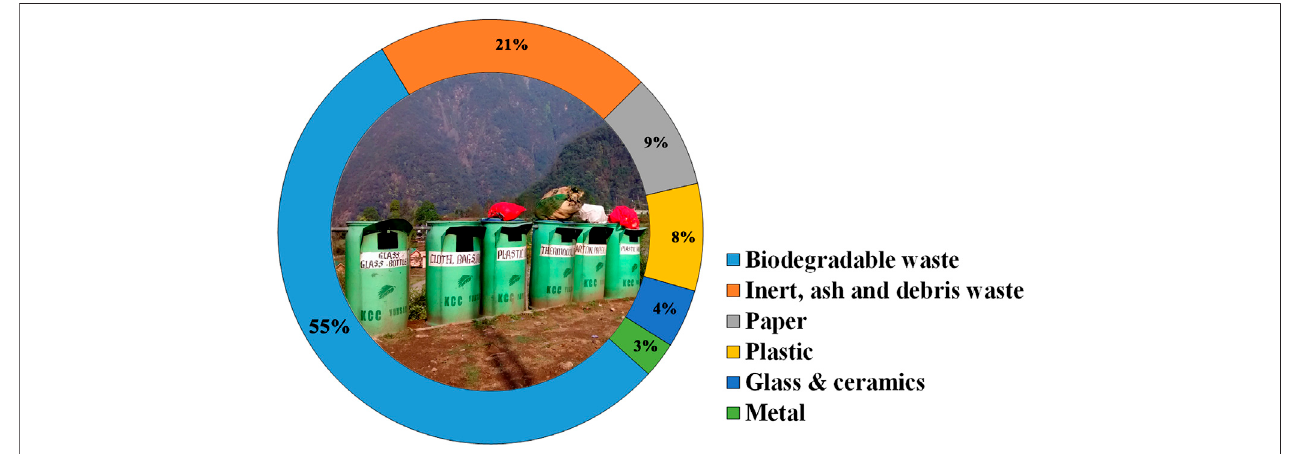
FIGURE3| Thecomponentfraction ofMSW generated intheIHR.The mostdominantfraction comprises biodegradablewaste, followedbyinert, ashand debris, paper, plastic, glass and ceramics, and metals (Data source: Kumar S. et al., 2016). The picture of the waste segregation bins at the center of the image is taken at the base of the trekking route of Khangchendzonga National Park, West Sikkim. The bins are arranged by Khangchendzonga conservation committee (KCC) based at Yuksom, West Sikkim.